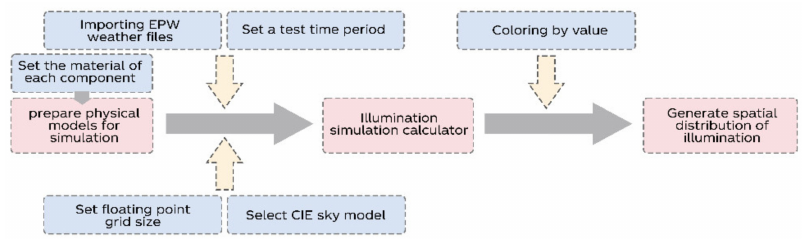
Figure 2. Simulation model of the main library of Shanghai Jiao Tong University.